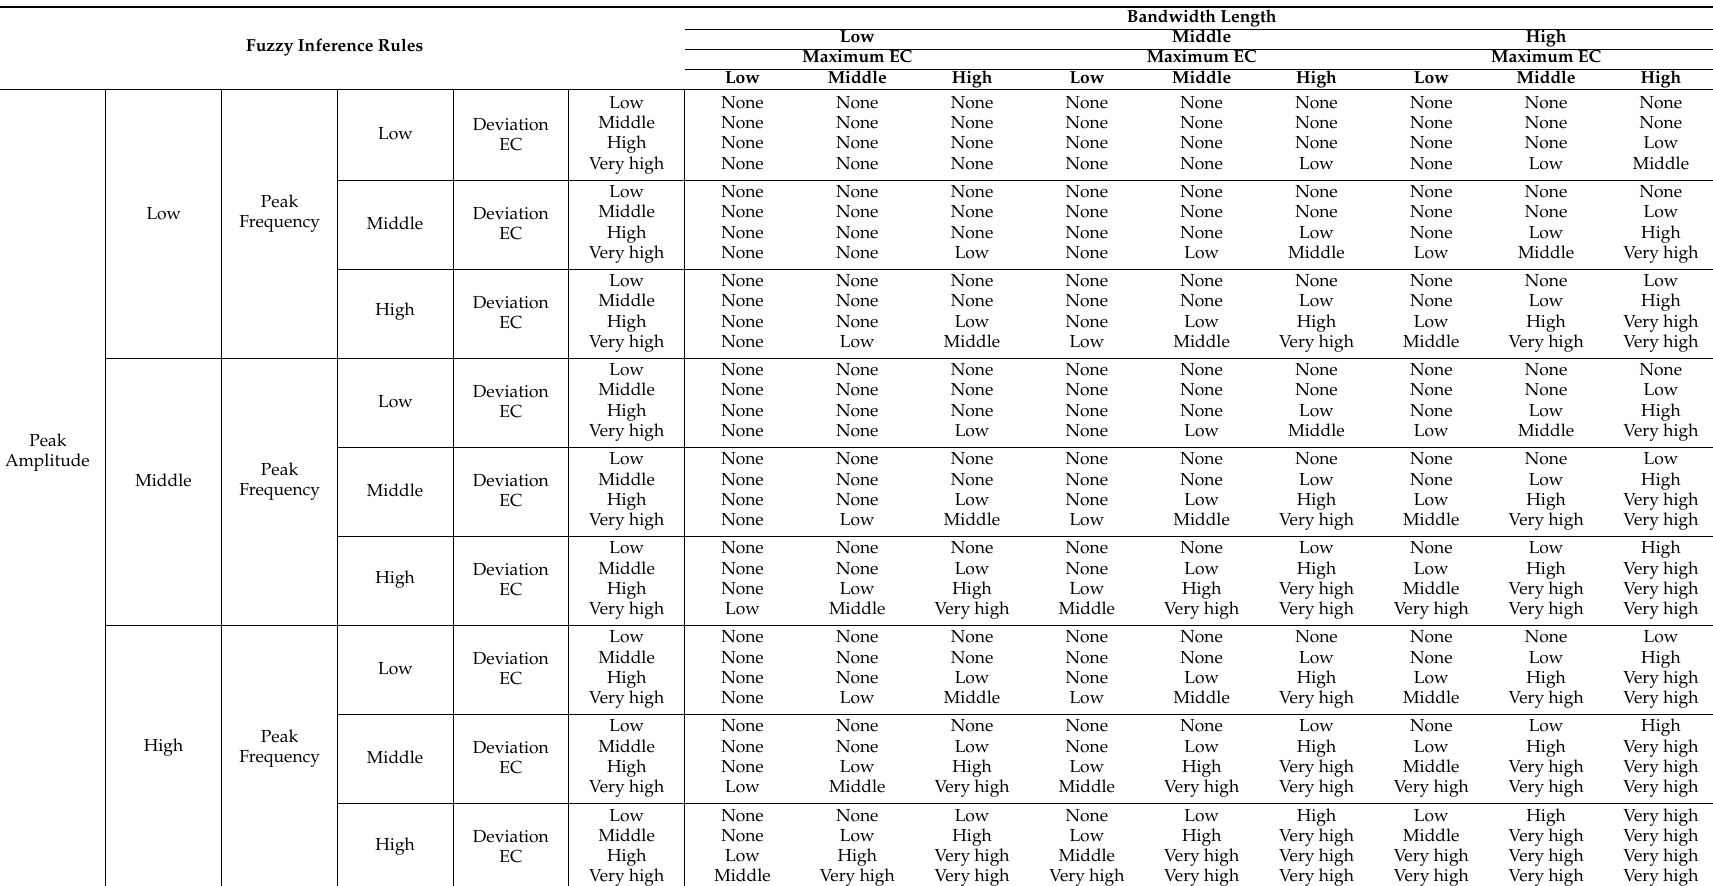
Table 2. Rules of the fuzzy inference phase about the electrical conductivity (EC) traits considered in the study. The rules are applied to the input variables: maximum EC , deviation EC , bandwidth length , peak frequency and peak amplitude and, with membership functions equal to low , middle , high , and very high , they provide, as outcomes, the probability to find a not healthy